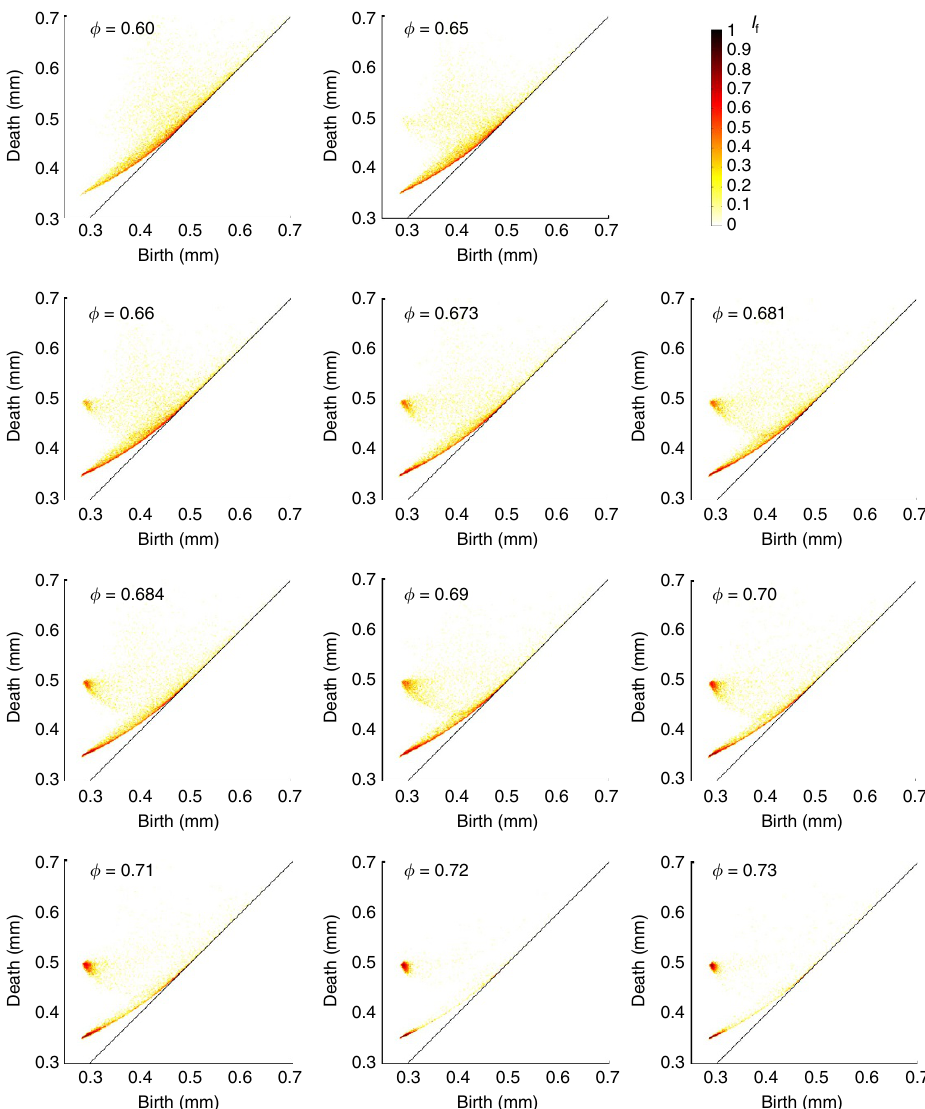
Figure 8 | Evolution of persistence diagram as a function of packing density / . Persistence diagrams PD 2 of sphere packings (subsets of 4,000 beads) over the density range f ¼ 0.60 (cid:2)